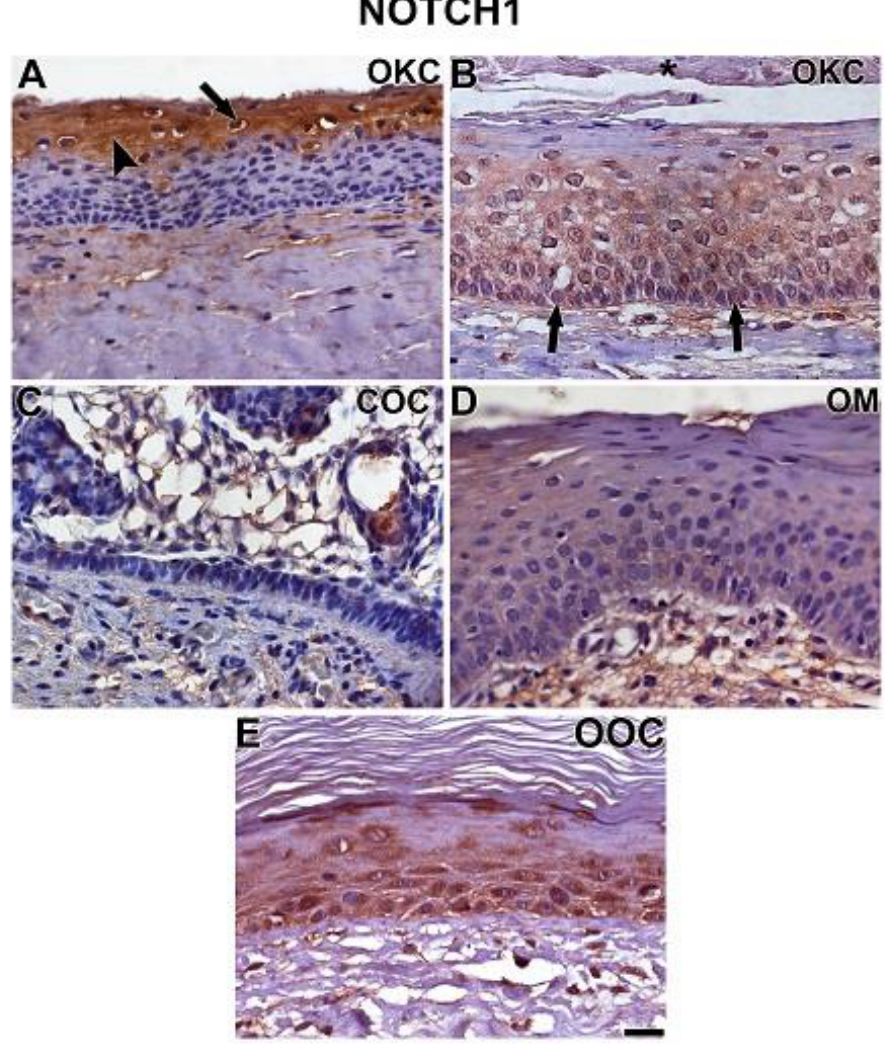
Figure 1. Immunostaining of NOTCH1 in OKC ( A , B ), COC ( C ), OM ( D ), and OOC ( E ). NOTCH1 exhibited intense and uniform cytoplasmic ( A , arrowhead) staining in epithelial layers adjacent to the cystic lumen. Strong nuclear staining was observed in some cells of the upper parabasal layers ( A , arrow). In some cases, basal ( B , arrows) and parabasal layers showed NOTCH1 expression. COC exhibited a weak and selective NOTCH1 expression in a few cells of the basal layer. Staining of ghost cells was observed around the plasma membrane ( C ). A very weak NOTCH1 expression was seen in OM ( D ), especially in the basal and lower suprabasal layers ( D ). OOC showed basal and suprabasal staining ( E ). Scale bar: 20 µm.